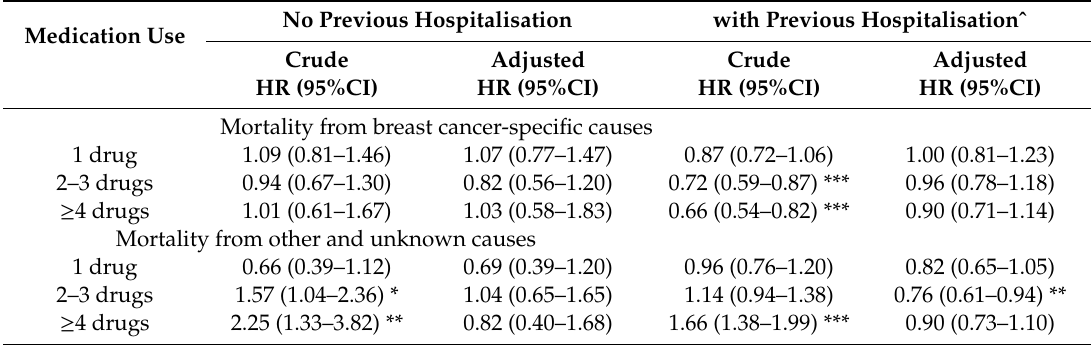
Table 4. Cox regression survival analysis showing the e ff ects of medication use on mortality from breast cancer-specific causes and other and unknown